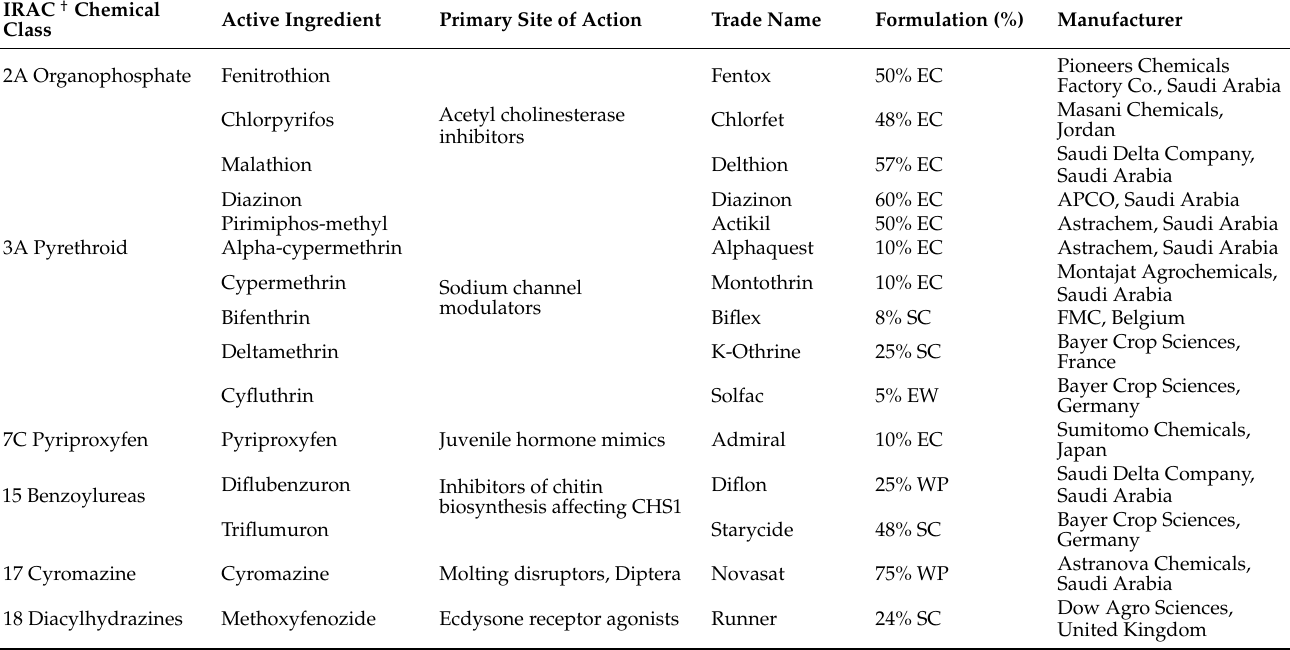
Table 1. Insecticides used in the Musca domestica